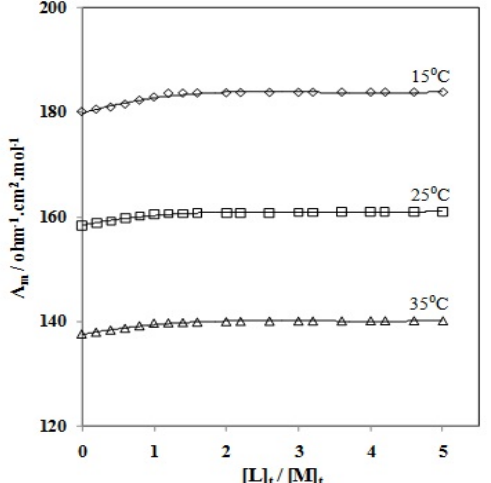
Figure 2. Molar conductance (S cm 2 .mol − 1 ) vs . [CMCR]/[Ti(OH)(OH in pure AN at various temperatures.